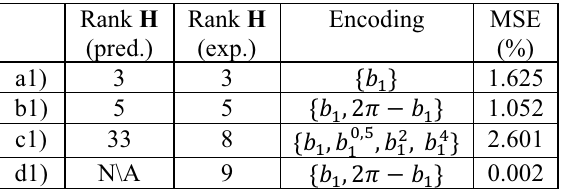
Table 2. Summary of results from figure 3. The encoding variable (cid:20) (cid:17) is a one-to-one mapping of the * coordinate of each point to a linear phase modulation of the wavefront from 0 to 2- in distinct regions of the DMD screen.